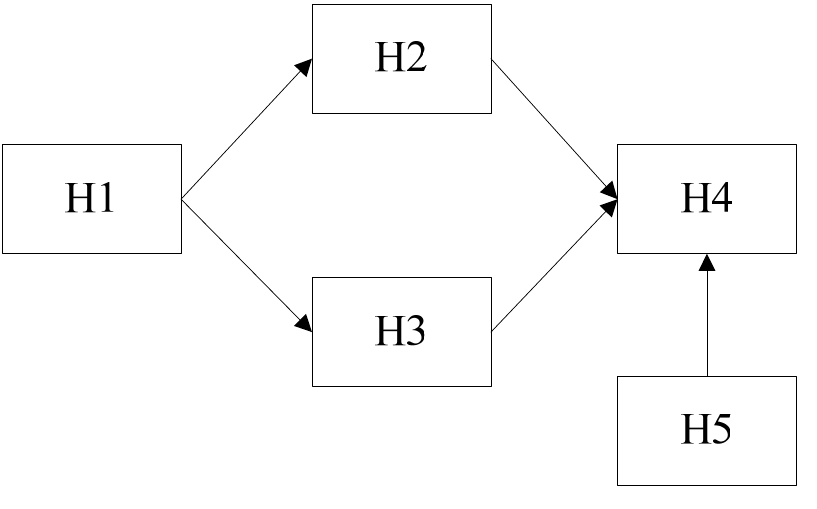
Figure 1. Research framework.